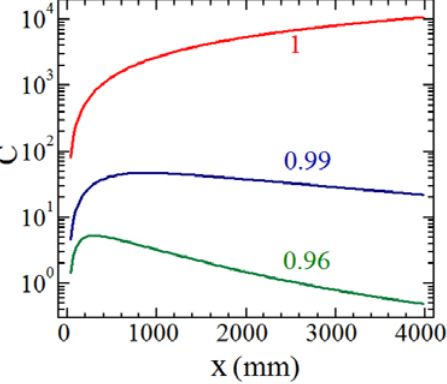
Figure 3. C-parameter for increasing distances x between the laser and the target by varying the ratio d/f, reported near each curve for ease of comparison. All curves have been calculated for typical values of diode laser parameters: w = 8°, w = 14°,  = 1.31  m, 0x 0y l = 0.1mm , n = 3.32,  = 3.5, R = 0.29 and for a lens of numerical aperture NA = 0.5 eff 2 and focal length f = 8mm. The mirror reflectivity was taken R = 3